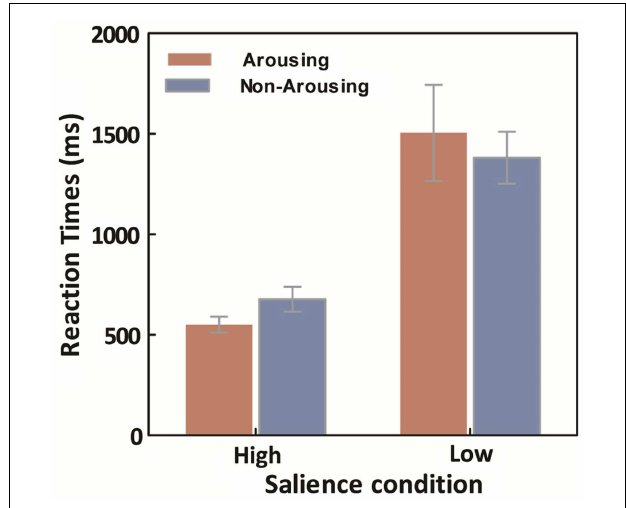
FIGURE 5 |Average across participants of within-participant median learning-trial response times, as a function of emotion and salience. Error bars represent